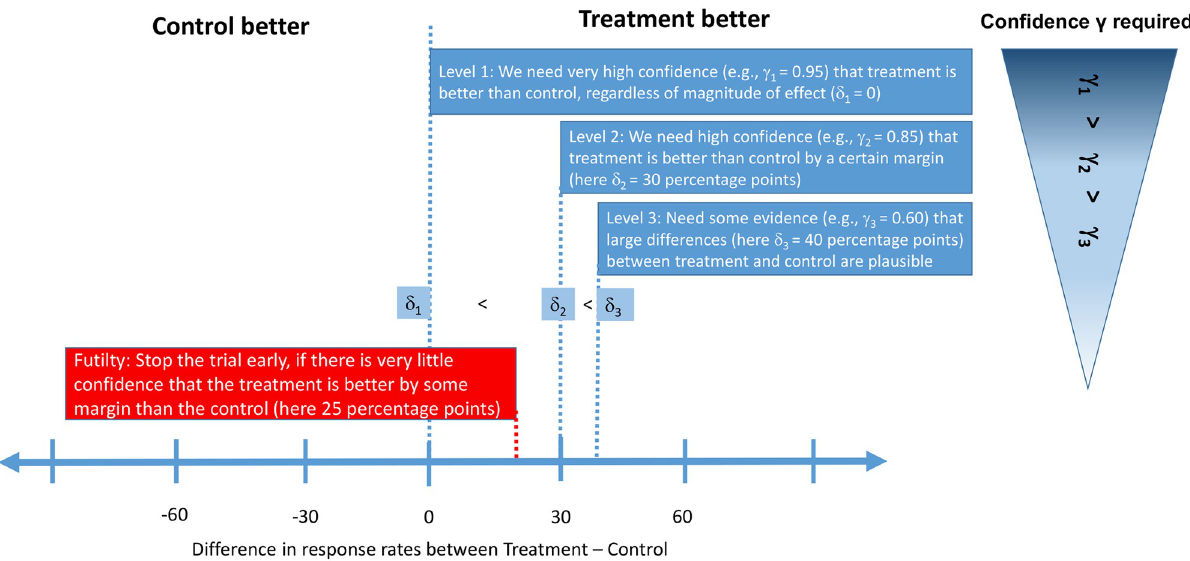
Fig 2. Schematic overview of decision rules used. On the x-axis, the difference in response rates between the control and treatment group (i.e. treatment effect) in percentage points is shown. At the two interim analyses, cohorts can be stopped early for futility, if there is very little evidence (interim analysis 1: less than 20%, interim analysis 2: less than 30%) that the treatment is better than control by 25 percentage points or more (red box). At all analysis time points, the same efficacy decision rules are used (blue boxes). Depending on the aim of the study, all or only certain levels